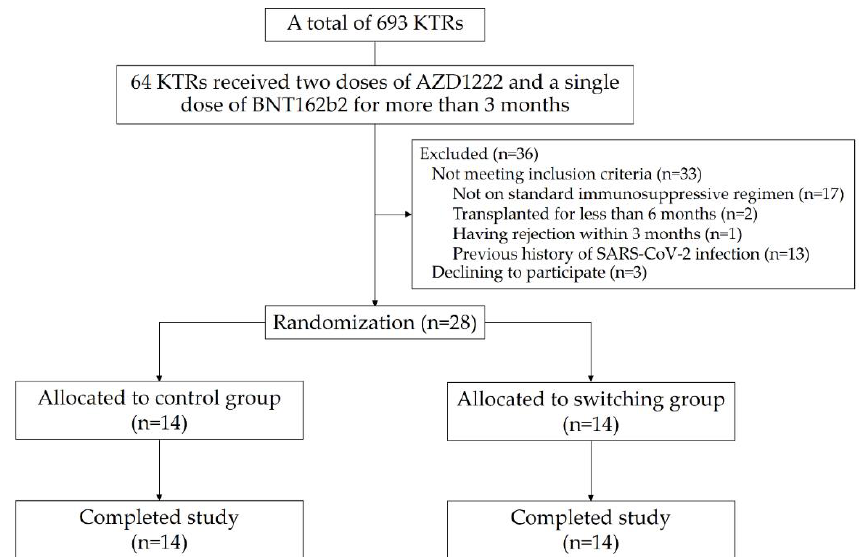
Figure 1. Flow diagram of the study participants. Table 1. Baseline characteristics of the study